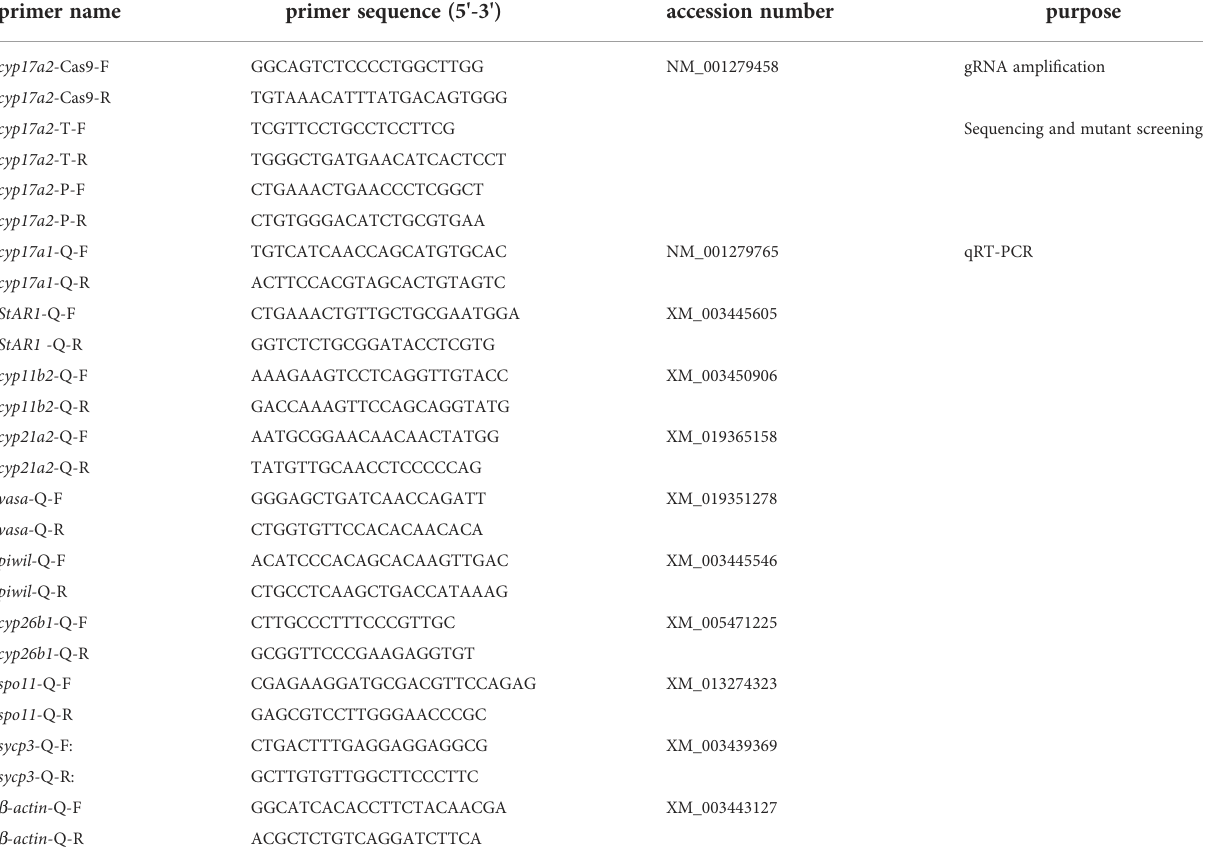
TABLE 1 Primers used in the present